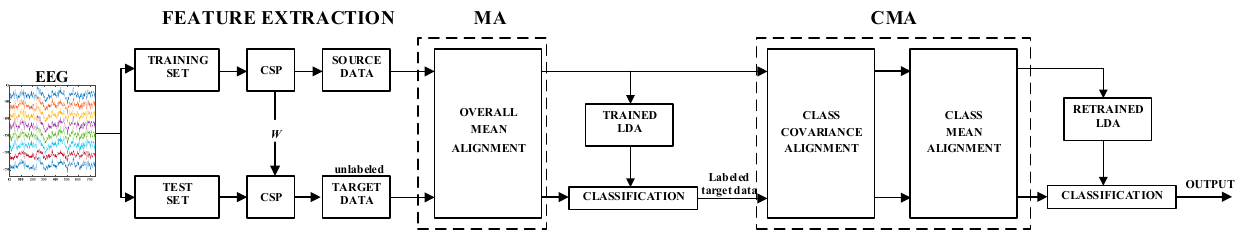
Figure 1. The flowchart of the CSP-MA-CMA method in this paper.